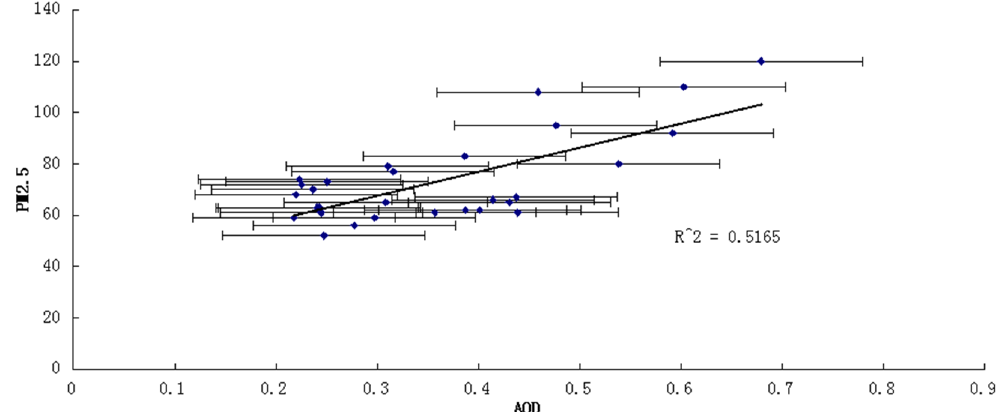
Figure 7. Correlation between the concentration of particles below 2.5 µm diameter (PM 2.5 ) and the aerosol optical depth (AOD). The blue points represent the date, the horizontal lines represent the positive and negative deviations, and the black line represents the linear